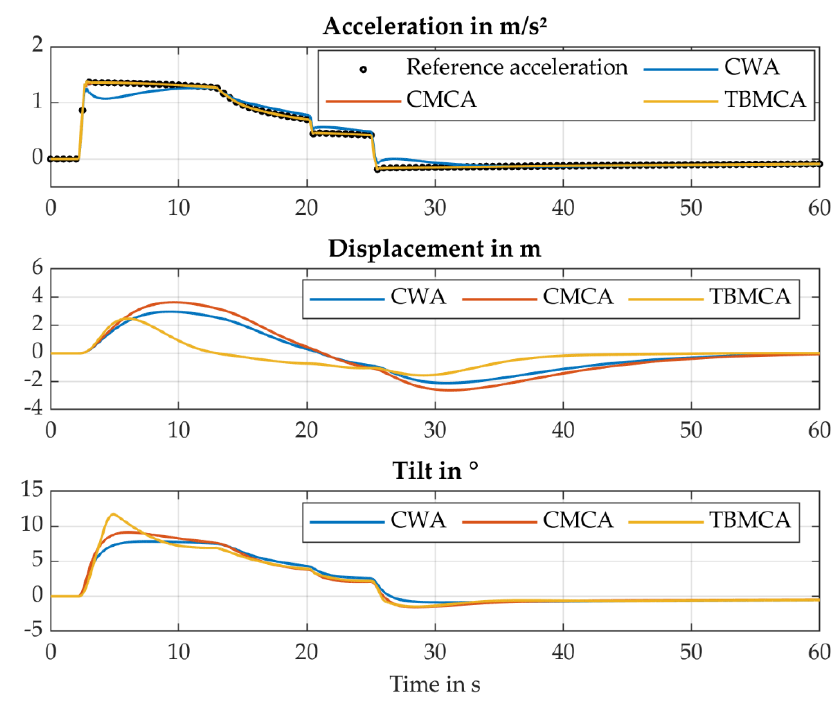
Figure 5. MCA outputs for APP = 50% and scaling factor = 0.5.